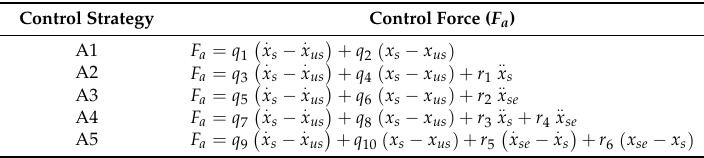
Table 1. Actuator force controller